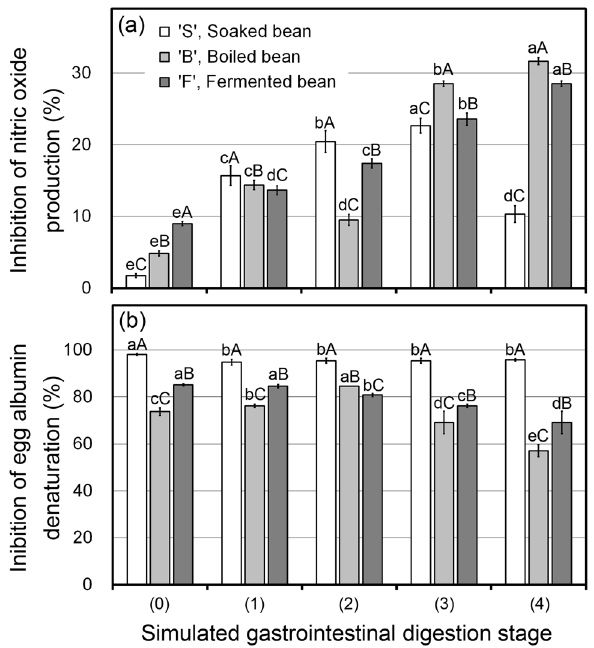
Figure 4. Changes in anti-inflammatory activity by the inhibition (%) of nitric oxide (NO) production ( a ) and egg albumin protein denaturation ( b ) of soaked (S), boiled (B), and fermented (F) soybeans at each digestion stage. Different lowercase and uppercase letters indicate significant differences ( P < 0.05) among digestion stages and among manufacturing steps,